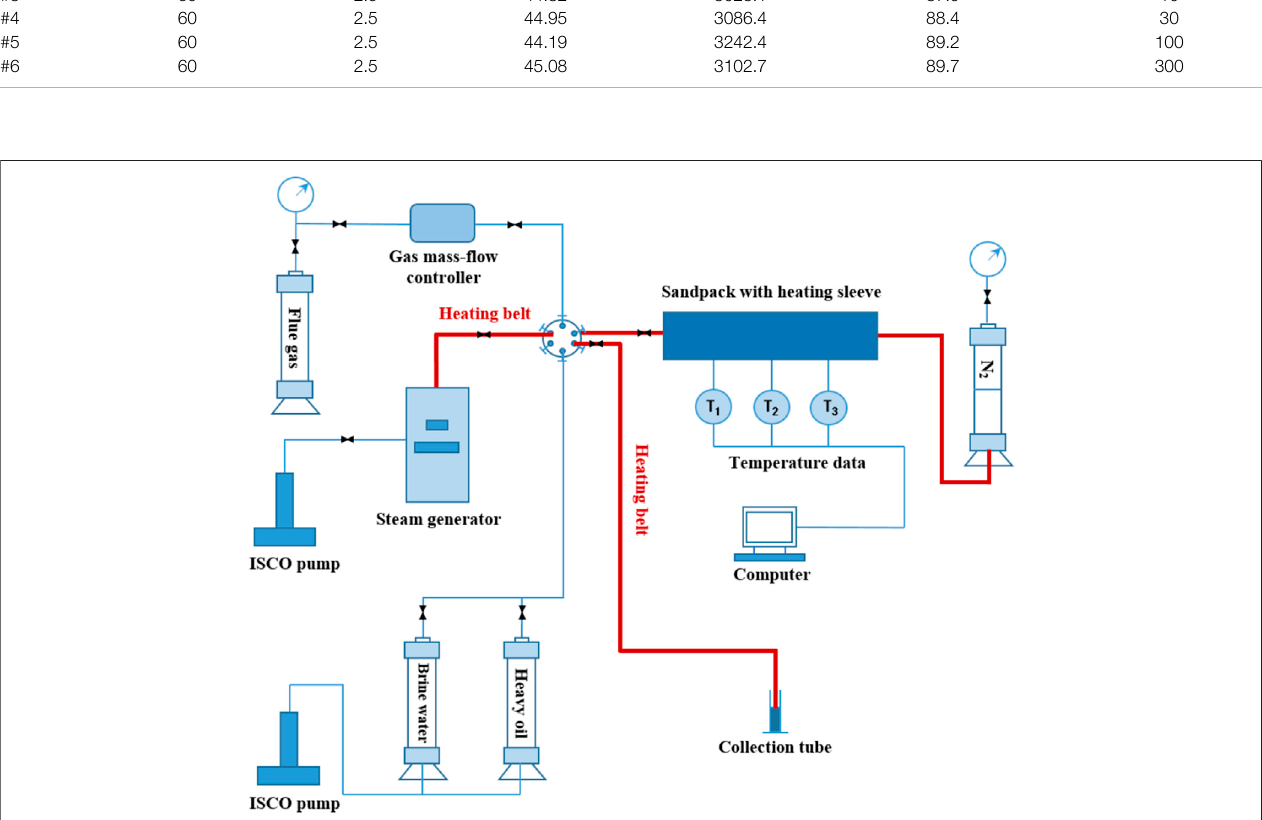
FIGURE 2 | Schematic diagram of the fl ue-gas-assisted steam CSS experimental setup in the laboratory.